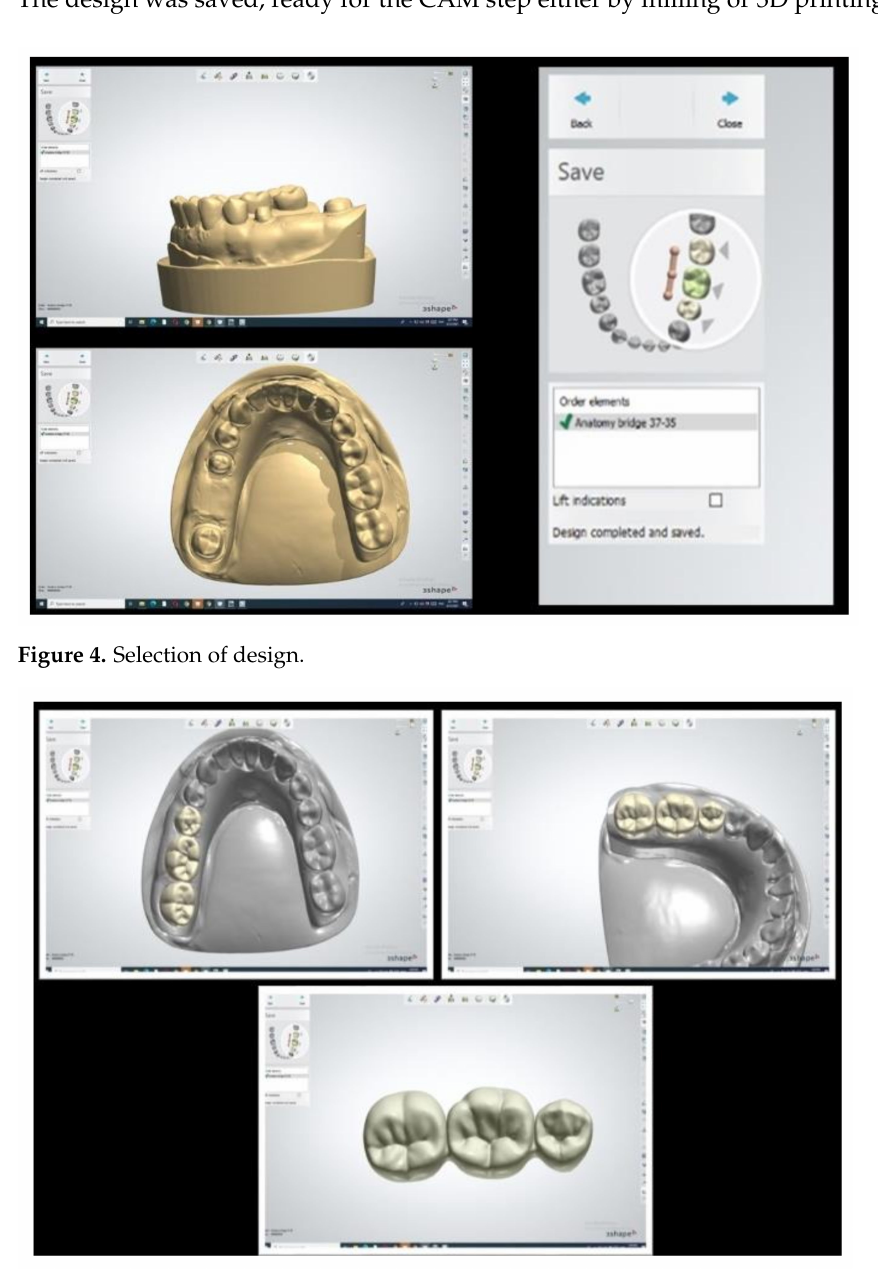
Figure 5. Finished FDP design. Milling the tooth-supported provisional dental prosthesis (group